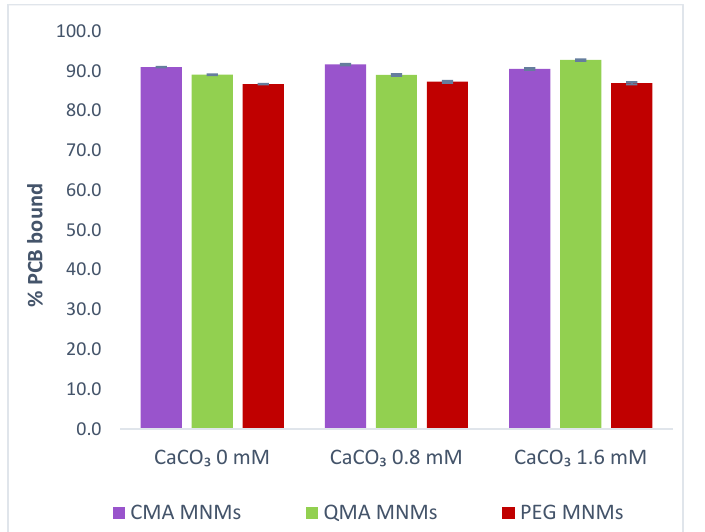
Figure 3. Effect of water hardness on the sorption efficiency of PCB 126 on CMA MNMs, QMA MNMs, and PEG MNMs. The water hardness concentrations represent soft (0 mM), moderately hard (0.8 mM), and hard (1.6 mM) waters.